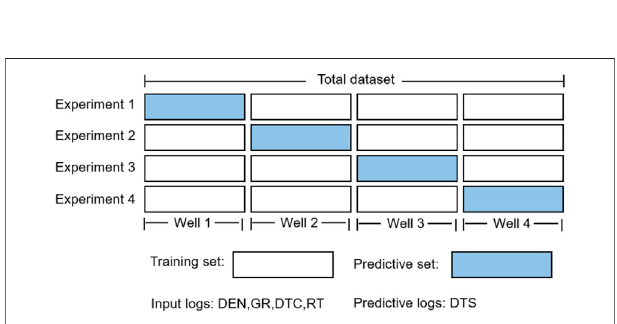
FIGURE 9 | Experimental datasets and schemes for predicting